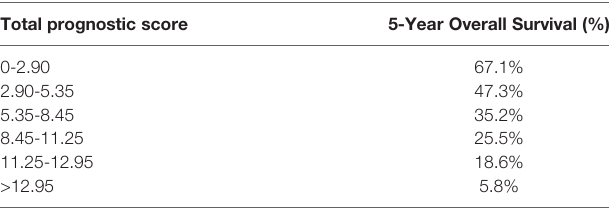
TABLE 4 | Six groups with distinct prognosis were identi fi ed by classi fi cation and regression tree model. Total prognostic score